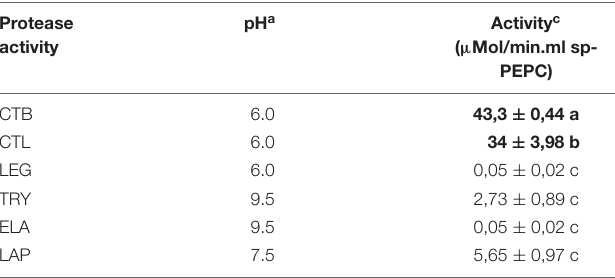
TABLE 2 | Identification of protease activities present in sp-PEPC fraction using specific protease fluorescent